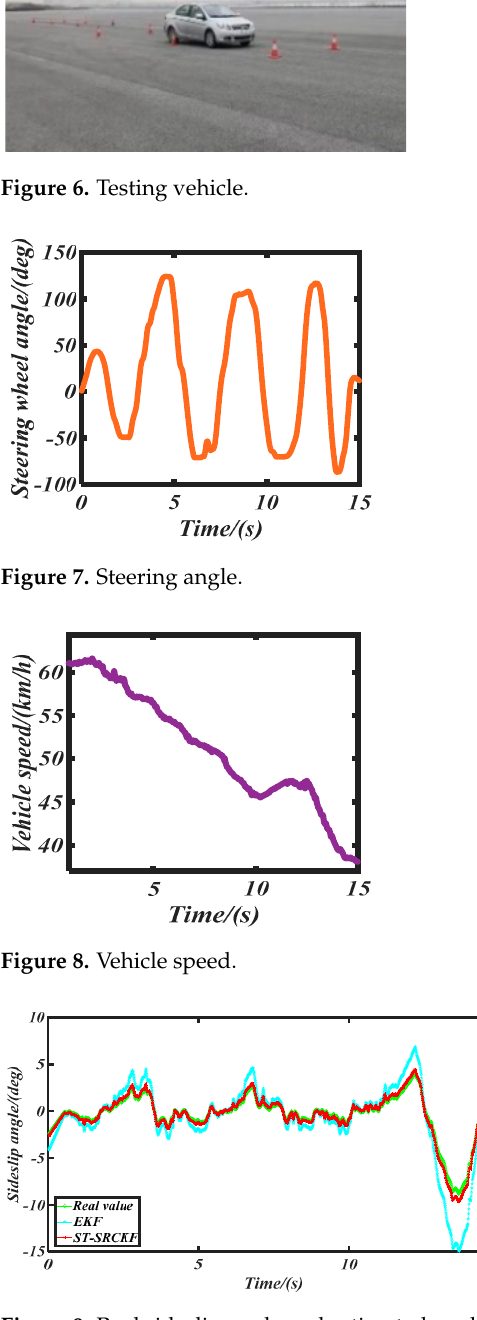
Figure 9. Real sideslip angle and estimated angle.